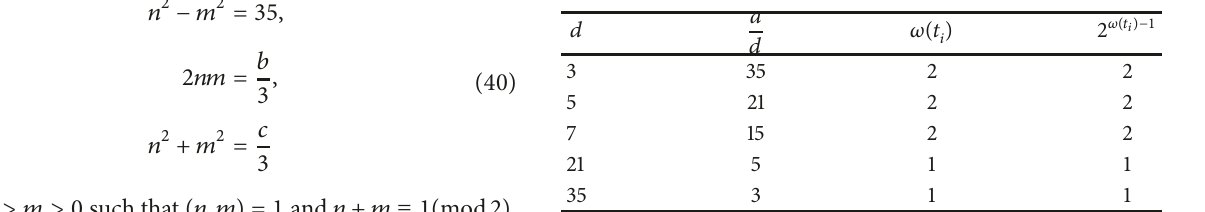
Table 4: Number of nonprimitive Pythagorean triples with com- mon leg 𝑎 = 105 for each value of 𝑑 .